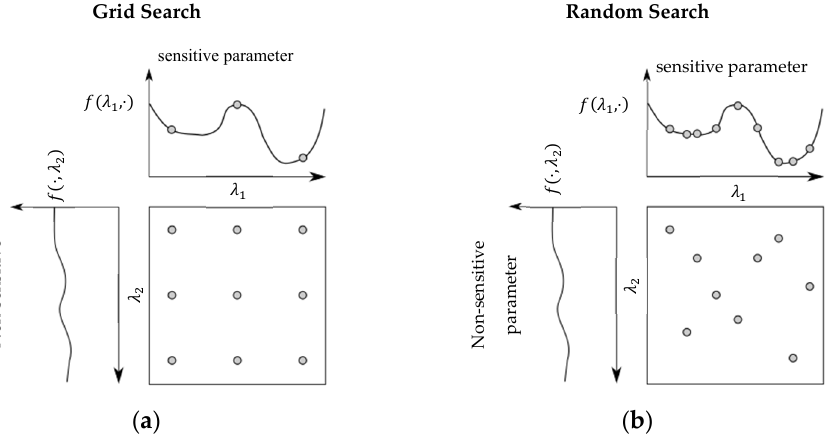
Figure 3. Comparison of Grid Search ( a ) and Random Search ( b ) for minimizing a function with two parameters.